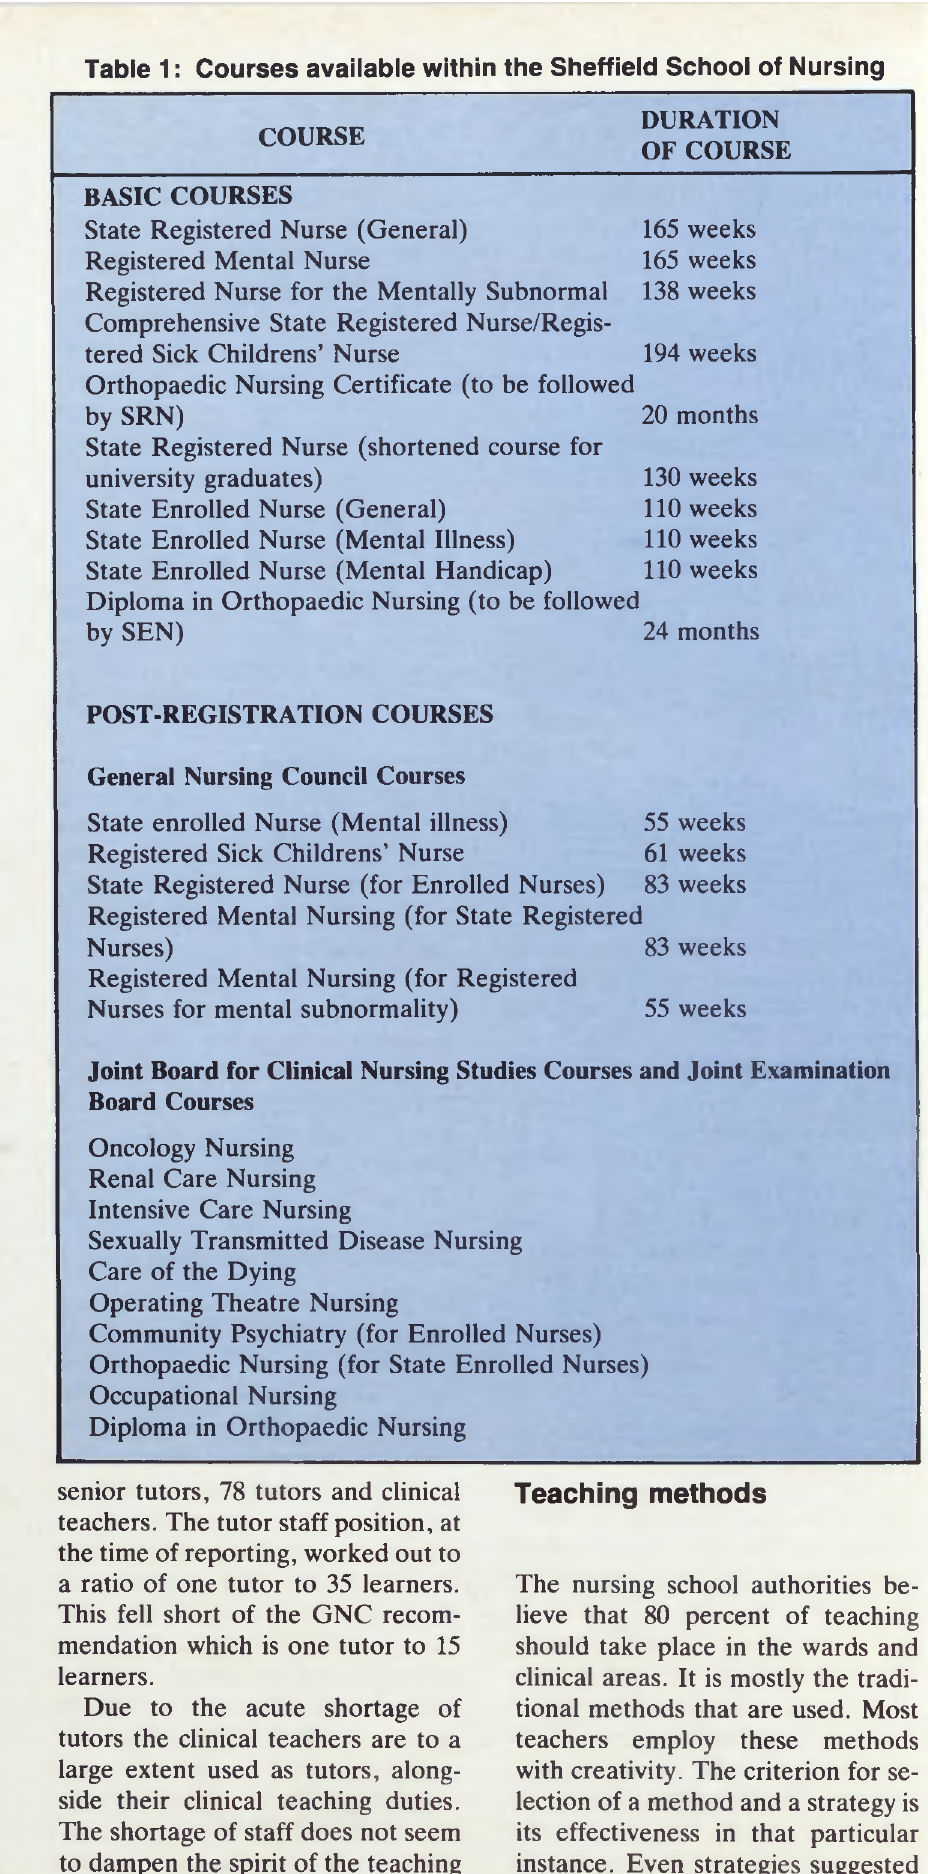
Table 1: Courses available within the Sheffield School of